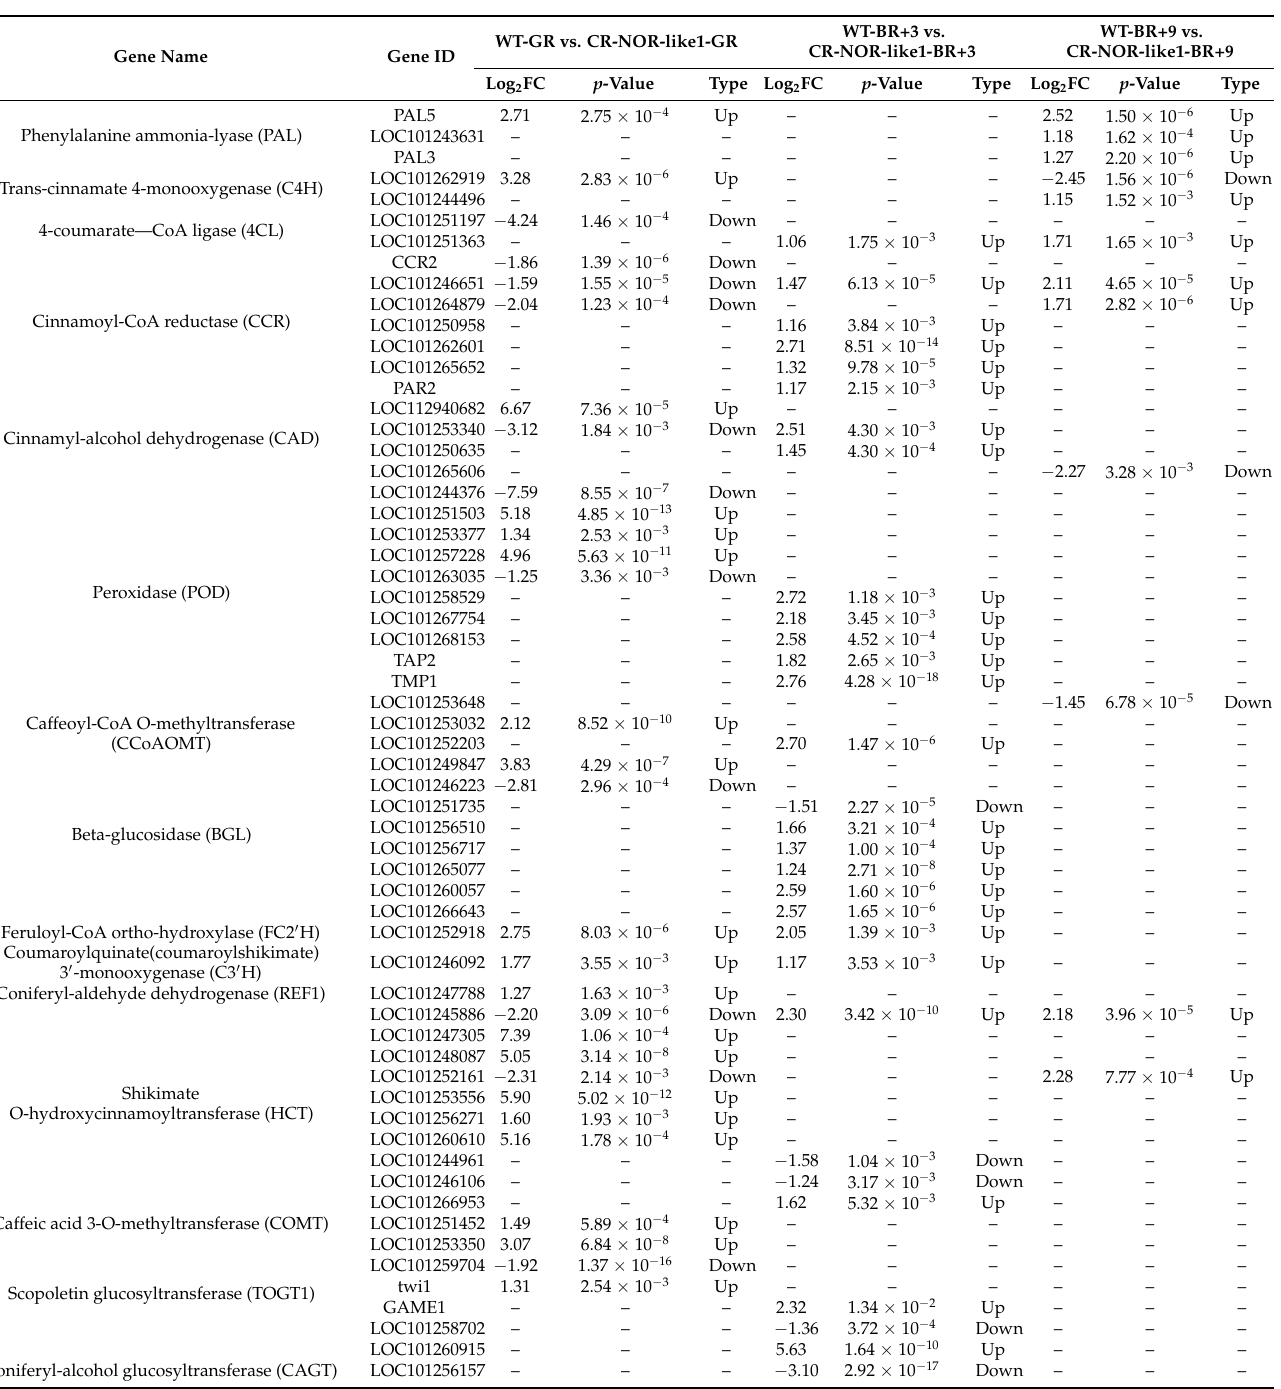
Table 2. List of DEGs related to phenolic